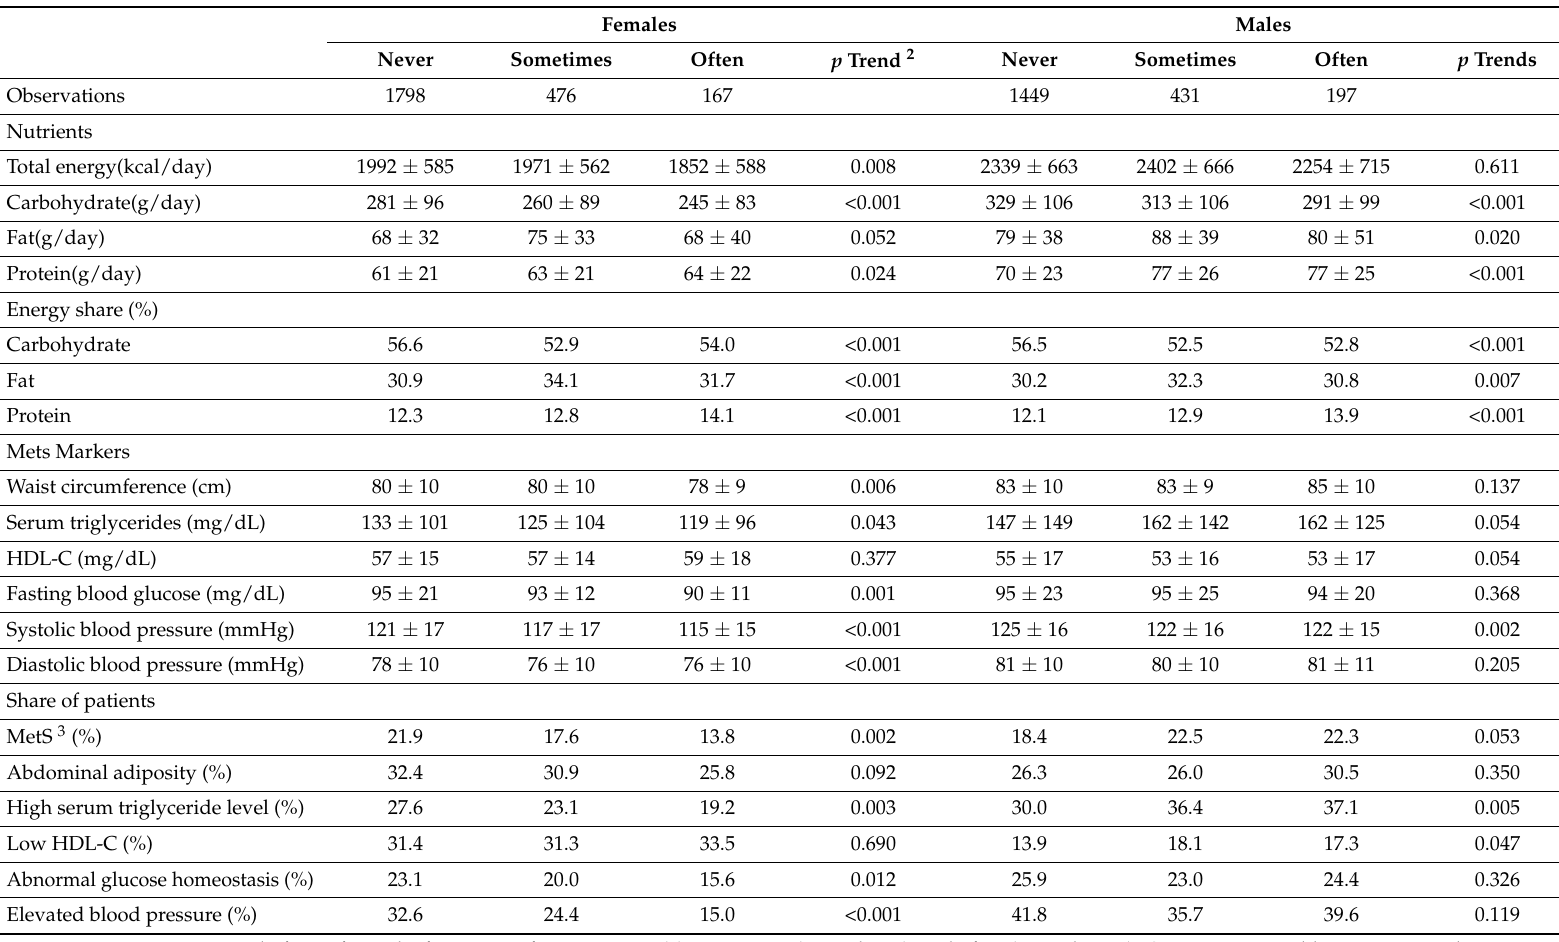
Table 2. Dietary intake and metabolic risk factors of participants by EAFH frequency 1 and sexes. Females Males Never Sometimes Often p Trend 2 Never Sometimes Often p